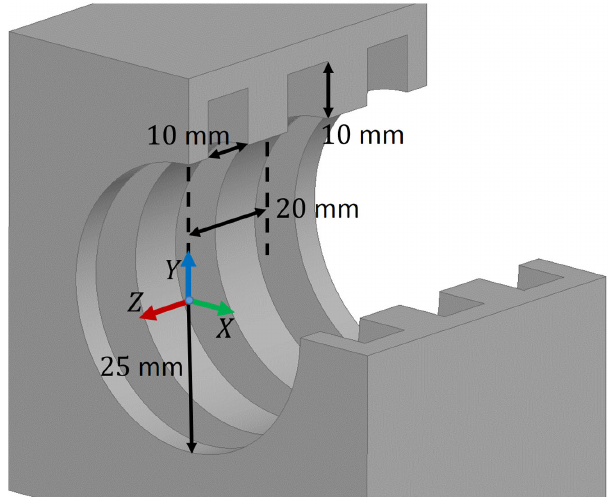
FIG. 3. The simulated bellows structure (three periods are